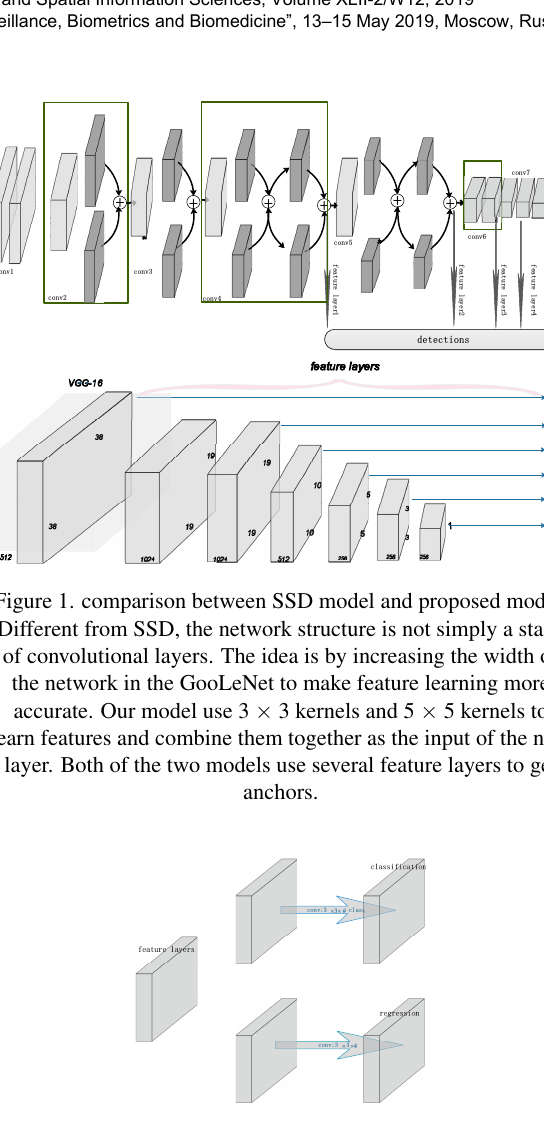
Figure 2. Simple subnet. Take the output of the base network as the input of classification subnet and location regression subnet. After two convolution layers, we get the regression results in the form of [x, y, w, h] and the classification results with confidence.